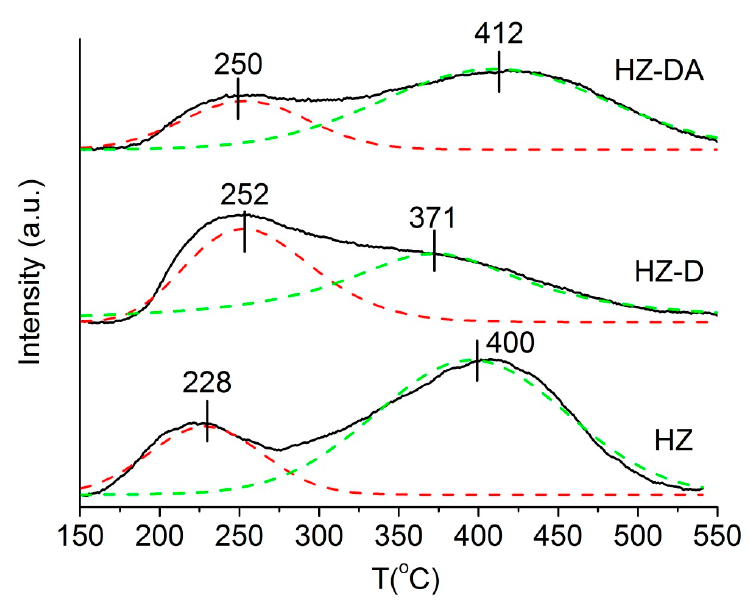
Figure 6. NH 3 ‐ TPD profiles of tested catalysts. Figure 6. NH 3 -TPD profiles of tested